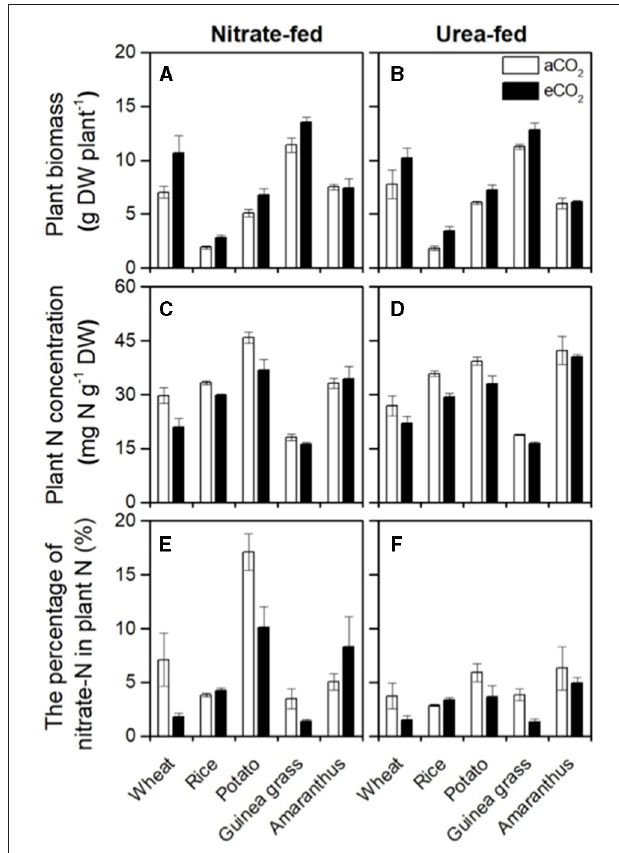
FIGURE 1 | Plant biomass (A,B) , plant N concentration (C,D) , and the percentage of nitrate-N in total N (E,F) in nitrate-fed or urea-fed plants in five species grown for 28 d in the chambers under ambient (aCO 2 ) or elevated (eCO 2 ) CO 2